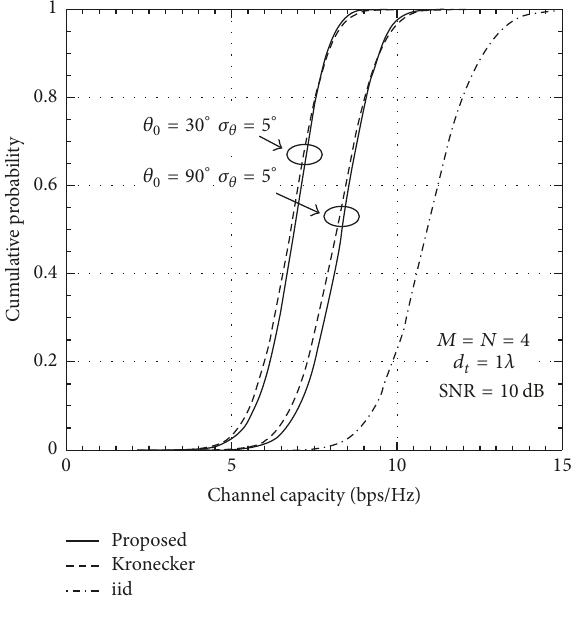
Figure 8: Comparison of channel